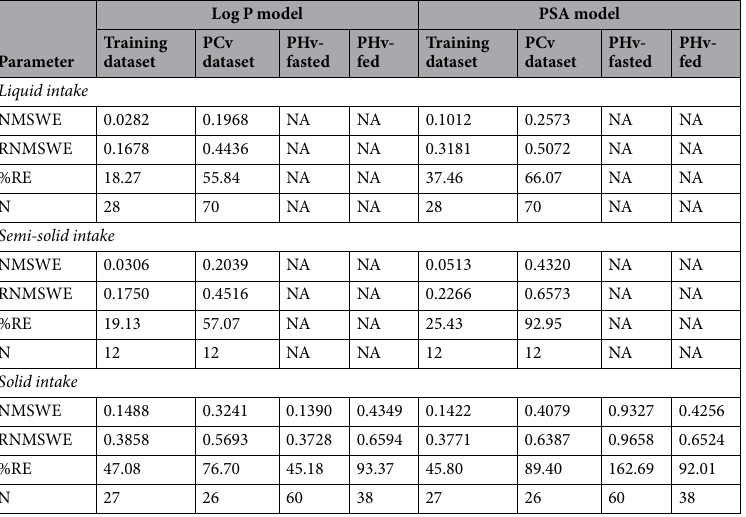
Table 4. Comparison of prediction accuracy of the predictive model for each